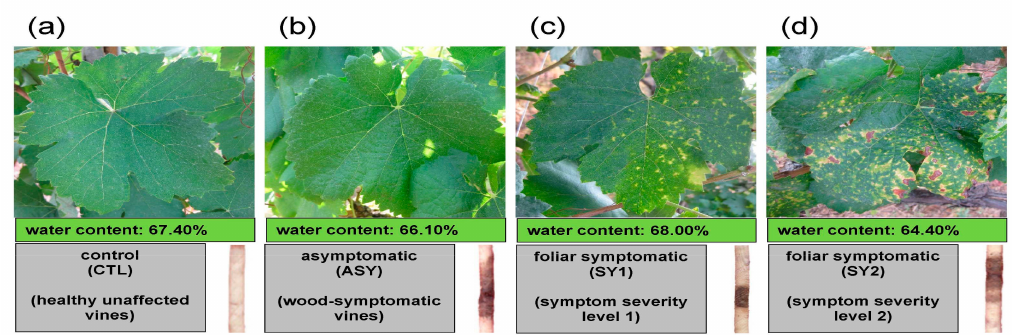
Figure 1. Sampling scheme: top = foliar symptom expressions of Esca complex disease (ESCA)-a ff ected Vitis vinifera L. ‘Malvasia Fina’ with ( a ) healthy, ( b ) asymptomatic, ( c ) chlorotic, and ( d ) spotted / scorched leaves that will later assume a tiger-stripe pattern. Middle = water status of leaf samples estimated after oven drying. Bottom left = Experimental leaf groups: Cross-sections of some healthy trunks showed most of the tissue to be non-necrotic, whereas a ff ected trunks showed moderate or large areas of brown wood streaks and necrotic tissues. Bottom right = cores of wood extracted with an increment